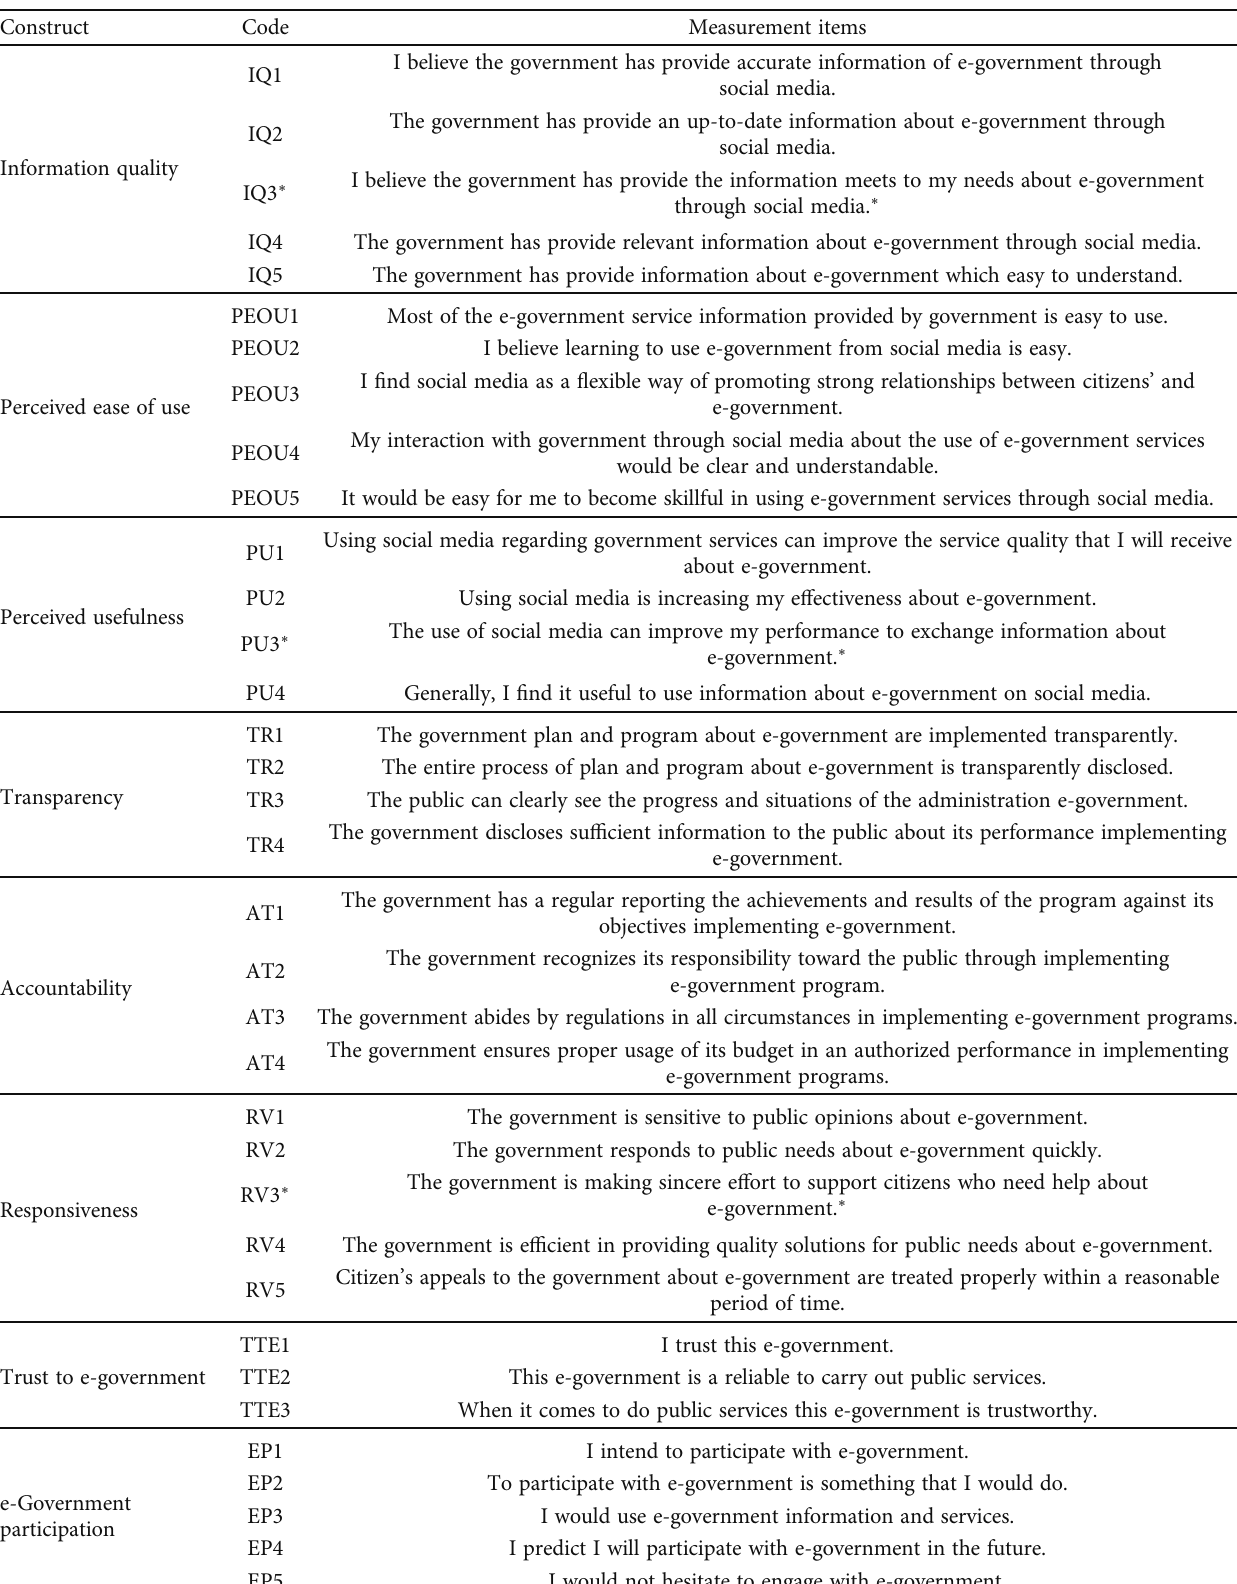
Table 1: Table of measurement